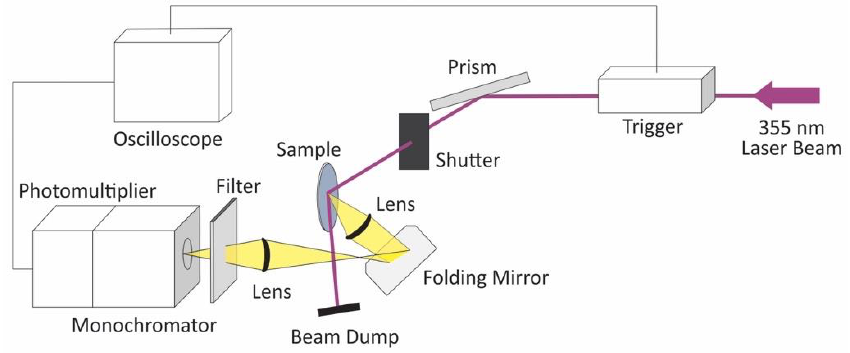
Figure 7. Scheme of the diffuse reflectance setup used for the transient photoluminescence measurements. The 355 nm laser excitation is shown in violet and the radiation emitted by the ZFO pellet is represented in yellow.